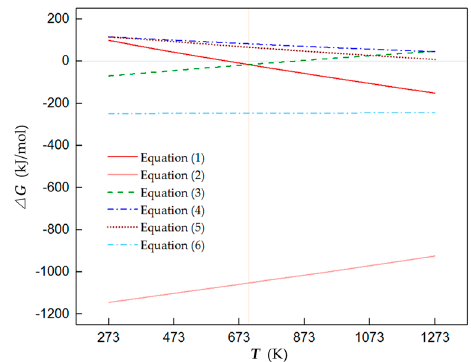
Figure 8. Gibbs free energies of relative chemical equations.